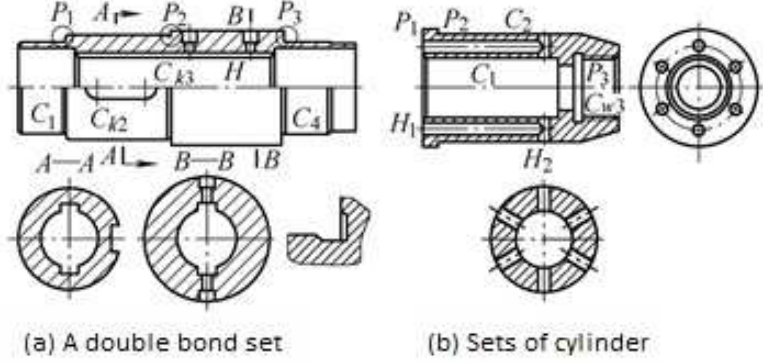
Figure 1. Expression views of several mechanical parts’ functional surfaces